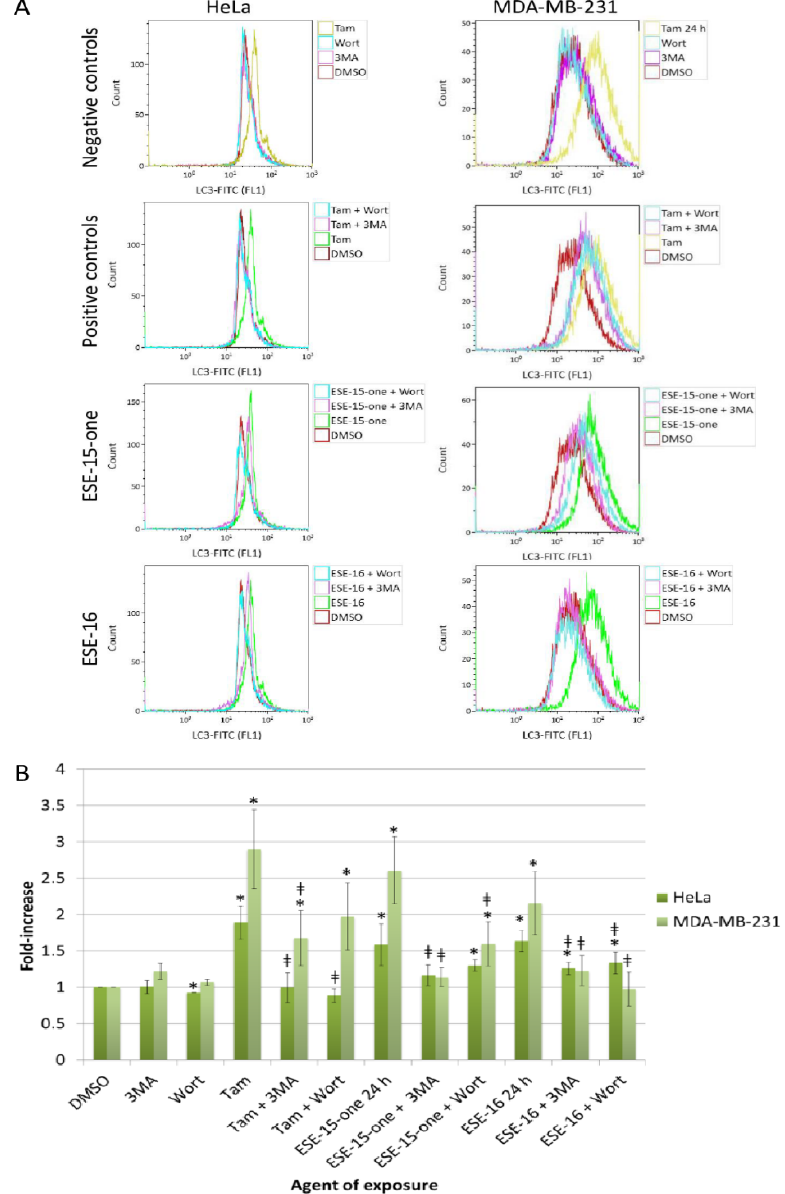
Figure 8. Overlay histograms ( A ) and bar chart ( B ) representing the fold-increase in LC3B detection in HeLa and MDA-MB-231 cells after a 24-h drug-exposure in parallel with autophagy inhibition. Cells were exposed to ESE-15-one and ESE-16 for 24-h either alone, or in combination with 3MA or wortmannin (Wort). LC3B was quantified by capturing fluorescence events of anti-LC3B/MAP1LC3B conjugated to Alexa Fluor 488. A right shift was detected after a 24-h drug-exposure in both cell lines, which was either completely or partially reduced with the addition of 3MA or wortmannin. Tamoxifen (Tam) was used as a positive autophagy control. The standard deviations are represented by error bars. * p < 0.05 when compared to the DMSO vehicle control; ‡ p < 0.05 in autophagy-inhibited samples compared to the relevant drug-exposed